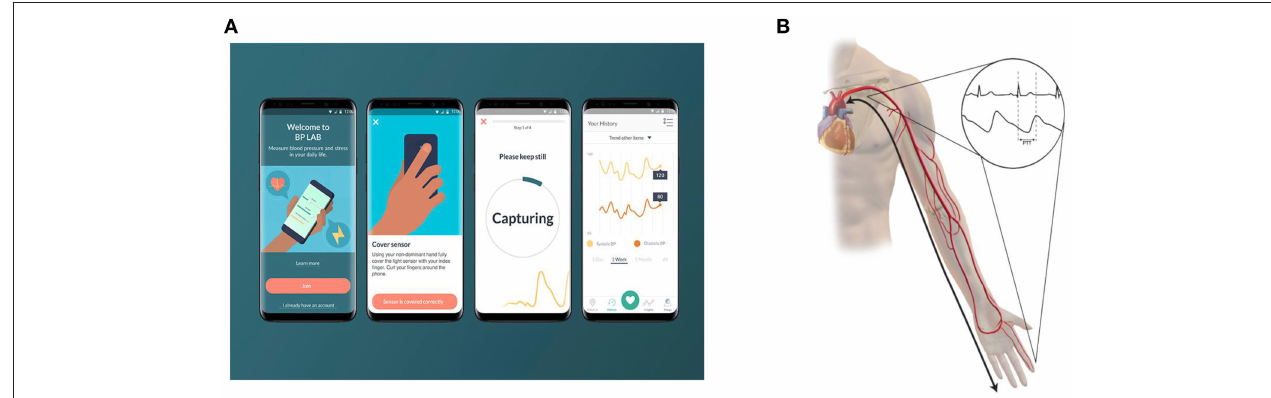
FIGURE 1 | Pulse transit time (PTT) based cuff-less blood pressure measurement. (A) depicts the My BP Lab App that has been developed by Samsung and the University of California San Francisco. To measure blood pressure, users place their index finger on the optical sensor on the back of the phone. (B) depicts the underlying principle of PTT based blood pressure measurement. PTT represents the time it takes for a pulse pressure wave to travel from its origin at the heart to a distal point. Since it is difficult to non-invasively measure a pulse waveform at the heart, the onset of the QRS complex is measured as a surrogate. The arrival of a pulse pressure wave at the finger or wrist can be measured using a photoplethysmography sensor.